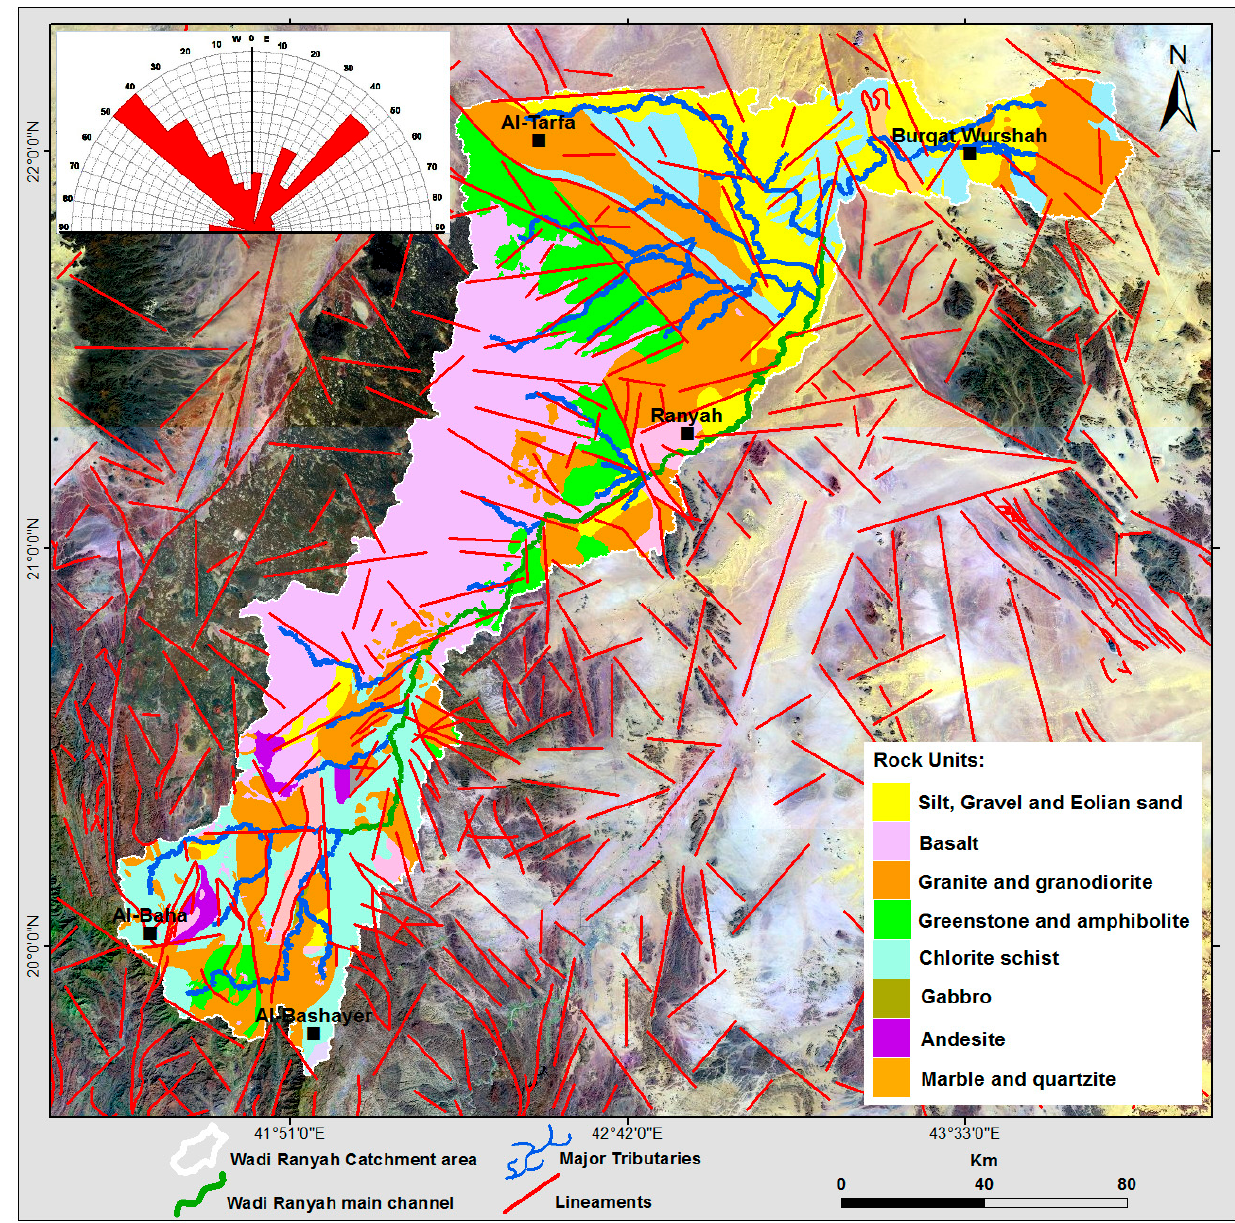
Figure 2. Geological map of the studied area (modified after [64]). Topographically, the upstream elevation of Wadi Ranyah in Baha ranges from 1750 to 1880 m above the mean sea level (amsl) in the high apparent stream areas, before gradually decreasing downstream (Figure 3). In the northeast, the elevation drops to about 857 m-amsl. The Wadi Ranyah stream network starts with a steep slope in the Baha Mountains and flows downstream, with the slope gradually decreasing along the way (Figure 4).